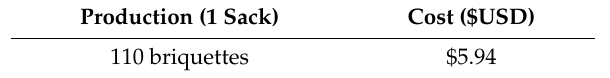
Table 6. Cost of production in dollar ($USD), per sack of sawdust and shavings